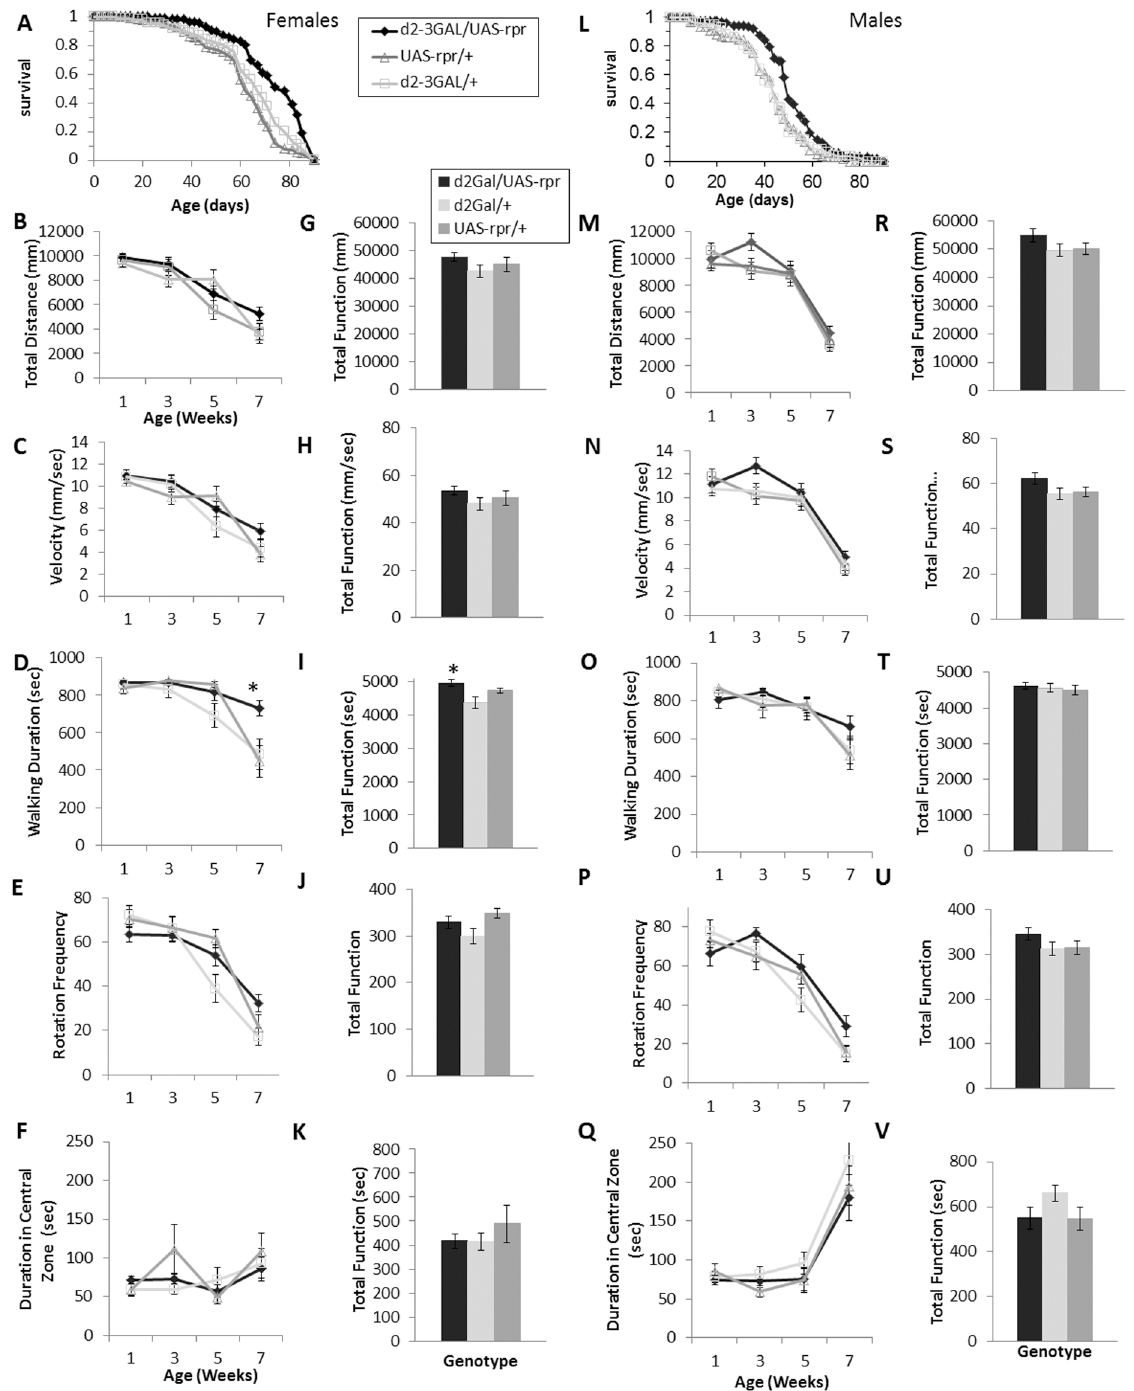
Fig 3. Exploratory walking senescence in long lived d2GAL/UAS-rpr male and female flies. ( A ) Survival of d2GAL/UAS-rpr once mated female flies compared to d2GAL4/+ and UAS-rpr/+ controls. Median lifespans and sample sizes were: d2GAL/UAS-rpr = 76 days, N = 120; d2GAL4/+ = 65 days, N = 120; and UAS-rpr/+ = 61 days, N = 120. Survival curves were compared using nonparametric log rank tests d2GAL/UAS-rpr showed an increased survival compared to both controls (P < 0.00001). ( B-K ) Exploratory walking senescence for a cohort of female flies of the indicated genotypes run in parallel with the survival experiment shown in (A). Data are shown as mean value for each parameter ± SEM, N = 12 for the indicated genotype ( B ) Female mean distance walked (mm) vs age. ( G ) Female Total Function of mean distance walked (mm). ( C ) Female Mean velocity (mm/sec) vs age. ( H ) Female Total Function of mean velocity (mm/sec). ( D ) Female Mean walking duration (secs) vs age. ( I ) Female Total Function of mean walking duration (secs). ( E ) Female